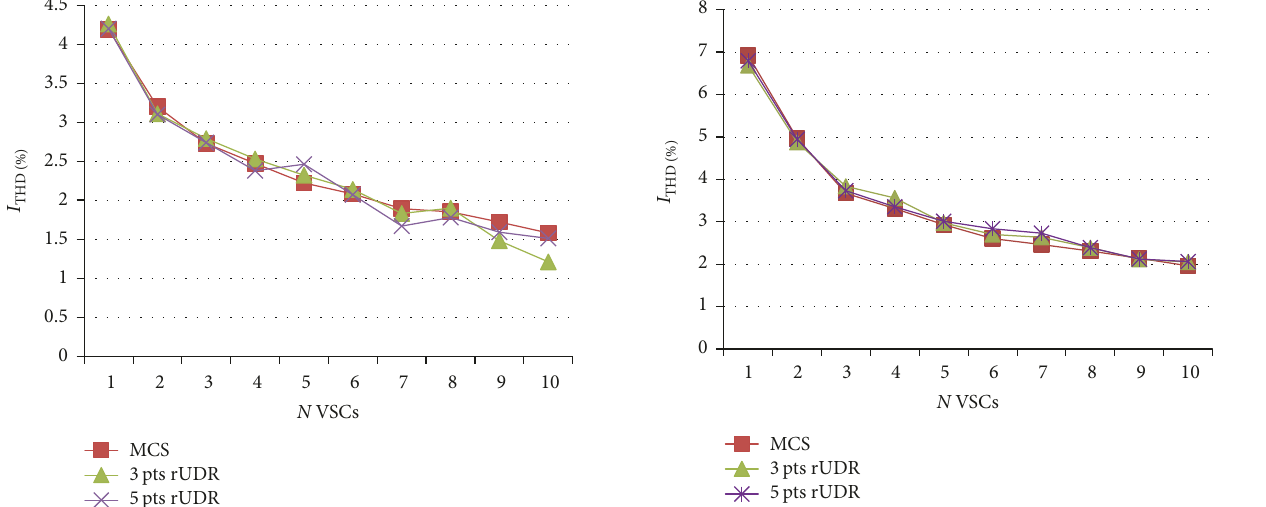
Figure 5: Predicted IgaTHD using MCS, rUDR 3 pts, and rUDR 5 pts under Filter Variation.